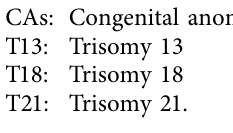
Figure S1: Sensitivity analysis on the pooled proportion of chromosomal disorders among births with congenital anomalies in Africa from January, 2000 to October, 2021. Figure S2: Funnel plot on the pooled proportion of chro- mosomal disorders among births with congenital anomalies in Africa from January, 2000 to October, 2021. Figure S3. Forest plot on the pooled proportion of Down syndrome (Trisomy, 21) among births with congenital anomalies in Africa from January, 2000 to October, 2021. Figure